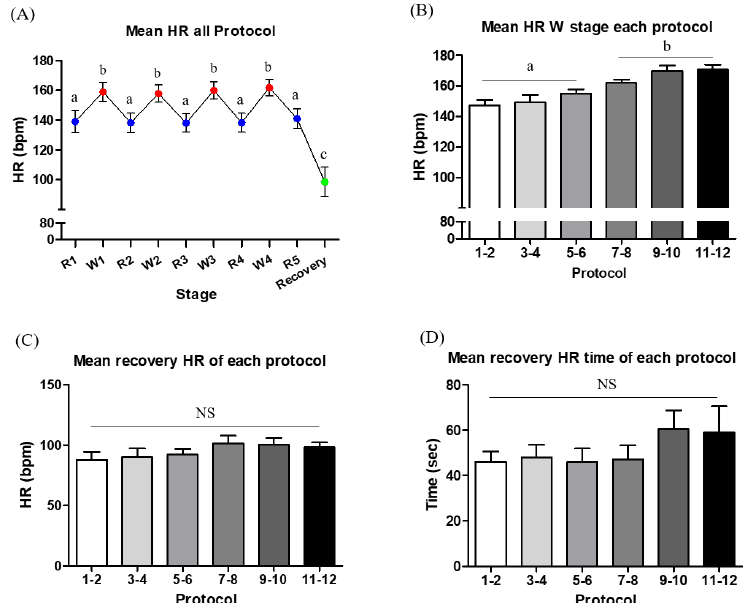
Figure 3. Analysis of the mean heart rate (HR) during exercise and the recovery HR after exercise. ( A ) The mean HR values for all dogs during incomplete resting stage (R1–R5), workout stage (W1– W4), and recovery. ( B ) Changes in the mean HR during the W stage according to treadmill exercise protocol (1–6 vs. 7–12). ( C ) The recovery HR at 1 min after exercise ( D ) The recovery HR time